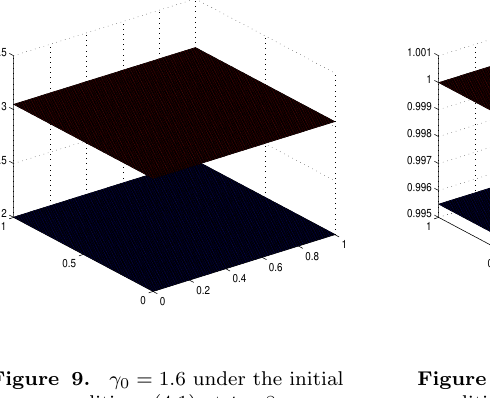
Figure 10. γ 0 = 2 under the initial conditions u ( x,y, 0) = 1 ,u ( x,y, 0)